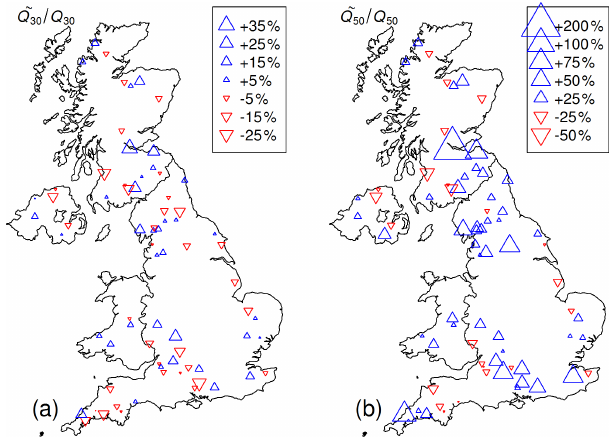
Figure 9. Percentage change of long-return-period flood magni- (cid:16)(cid:16) (cid:17) (cid:17) g Q T − 1 × 100% tudes computed under assumptions of sta- Q T tionarity ( Q T ) and non-stationary probability of exceedance ( g Q T ) . Shown for the 30-year event (a) and 50-year event (b)